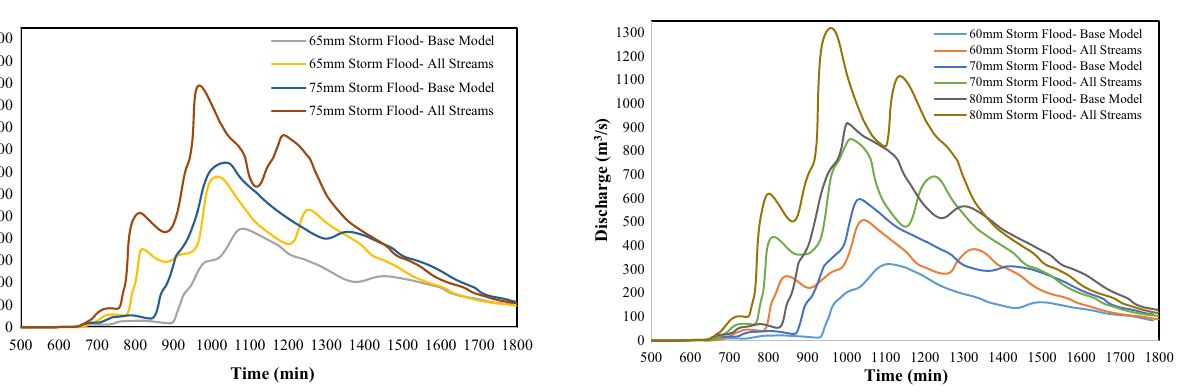
of calibrated GSSHA base model for five 24 h floods of 60–80 mm cumulative depths compared to hydrographs corresponding to GSSHA model by no diffusive wave simulation